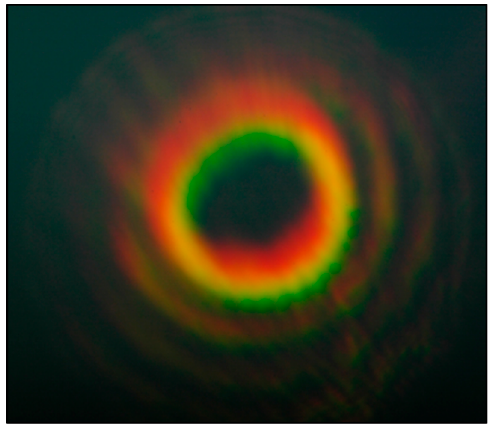
Figure 8. Multi-color vortex of charge +10. The color offset is a result of the diffraction into the first order.